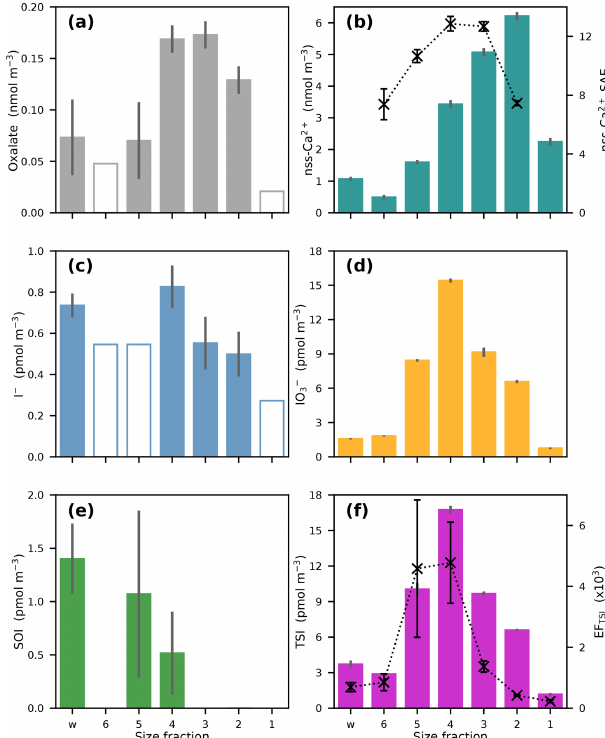
Figure 6. Concentrations of (a) oxalate, (b) nss-Ca 2 + , (c) I − , (d) IO − , (e) SOI and (f) TSI in the size fractions of sample 15. concentrations 3 3 ( w indicates the backup filter and particle size increases from stage 6 to stage 1 – stage cut-off diameters are given in the text). Crosses in (b) show the surface area equivalent (SAE) of nss-Ca 2 + (arbi- trary units) for impactor stages 2–6 and in (f) show the enrichment factors of TSI in each